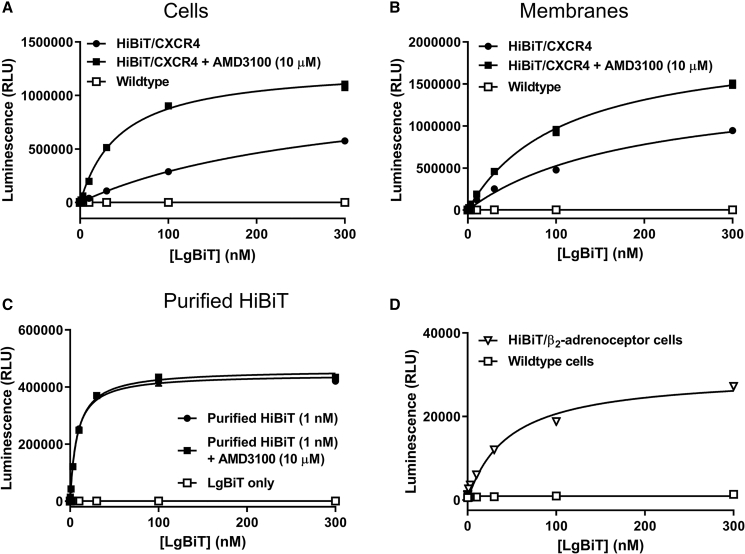
Investigation of the Effect of Protein Fusion on the Affinity of HiBiT-LgBiT Complementation(A–C) HEK293 cells expressing genome-edited HiBiT/CXCR4 (black symbols) or wild-type HEK293 cells (white squares) (A), membranes from HEK293 cells expressing genome-edited HiBiT/CXCR4 (black symbols) and wild-type HEK293 cells (white squares) (B), or purified HiBiT control protein (black symbols) were incubated with increasing concentrations of LgBiT in the absence (black circles) or presence (black squares) of AMD3100 (10 μM) (C).(D) HEK293 cells expressing genome-edited HiBiT/β2-adrenoceptor (downward triangles) or wild-type HEK293 cells (white squares) were incubated with increasing concentrations of purified LgBiT. Points are mean ± SEM and are representative of five (C and D), six (B), or seven (A) experiments performed in triplicate.